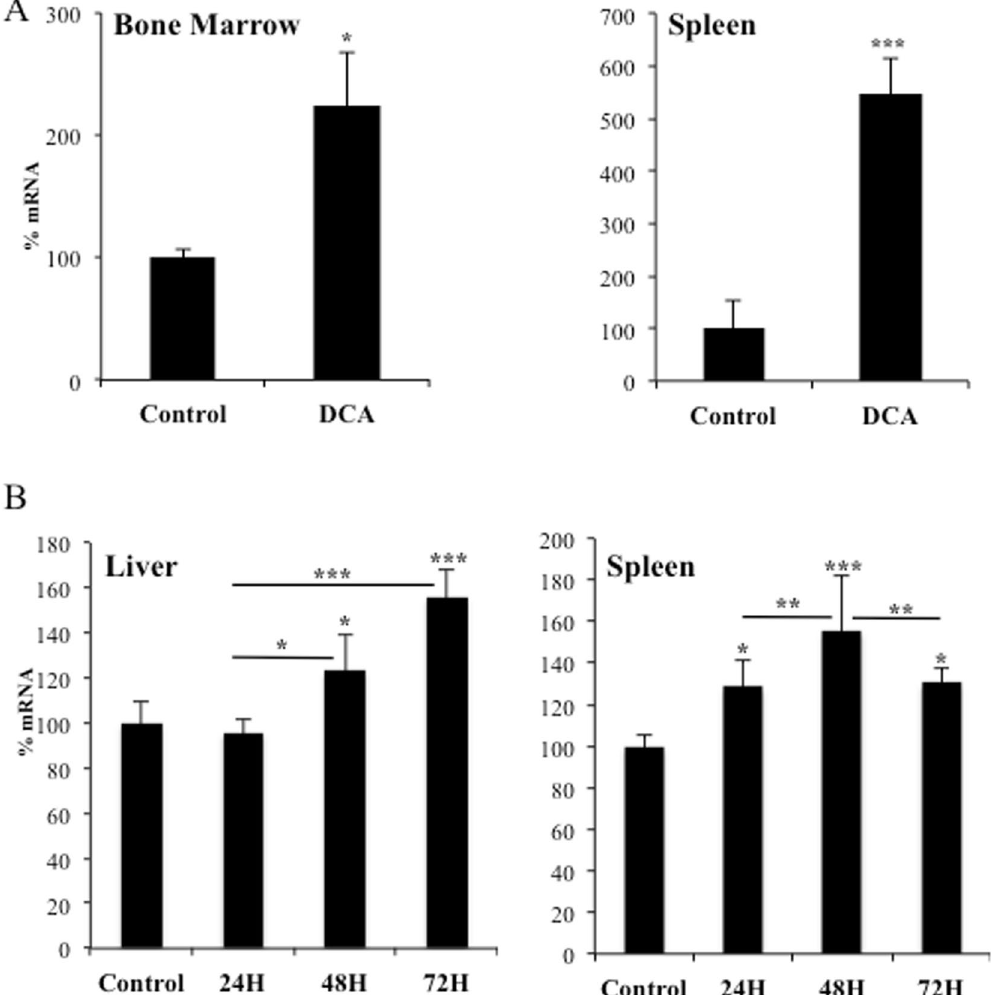
Figure 4. DCA induced LDLR expression in vivo . ( A ) NSG mice were engrafted with primary human AML cells. At day 80 post-graft, they were treated with DCA (n = 4) or leave untreated (n = 4). At day 140, mRNA from bone marrow or spleen was isolated and human LDLR mRNA expression was quantified by qPCR. The data represent means ± SD; * p < 0.05, ** p < 0.01, *** p < 0.005 student t-test compared to non treated mice. ( B ) B6 wt mice (n = 4/5 per group) were treated with a dose of DCA (50 mg/kg) everyday intraperitoneally and mouse LDLR mRNA was analyzed in spleen and liver at indicated time points. The data represent means ± SD; * p < 0.05, ** p < 0.01, *** p < 0.005 one-way ANOVA with post-hoc Tukey